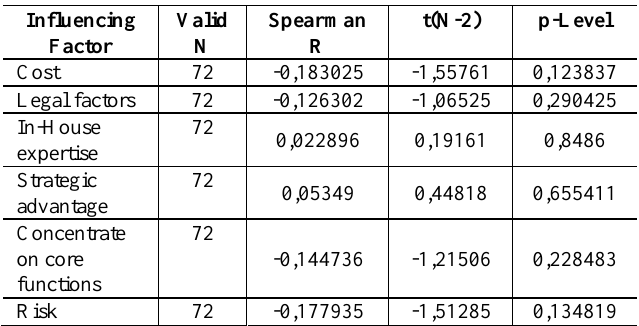
Table 7: Spearman correlation for size vs